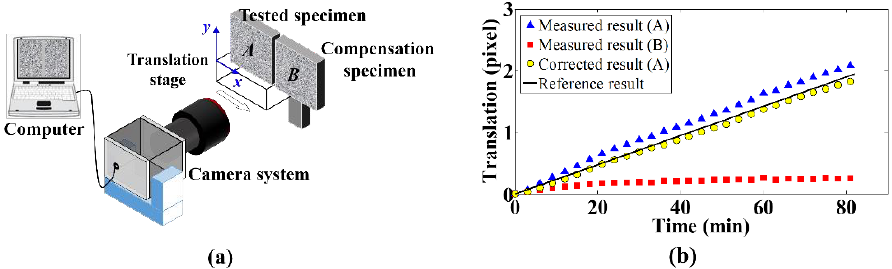
Figure 17. Experimental verification of the compensation specimen method for compensating the translation measurement error: ( a ) experimental arrangement and ( b ) experimental results.